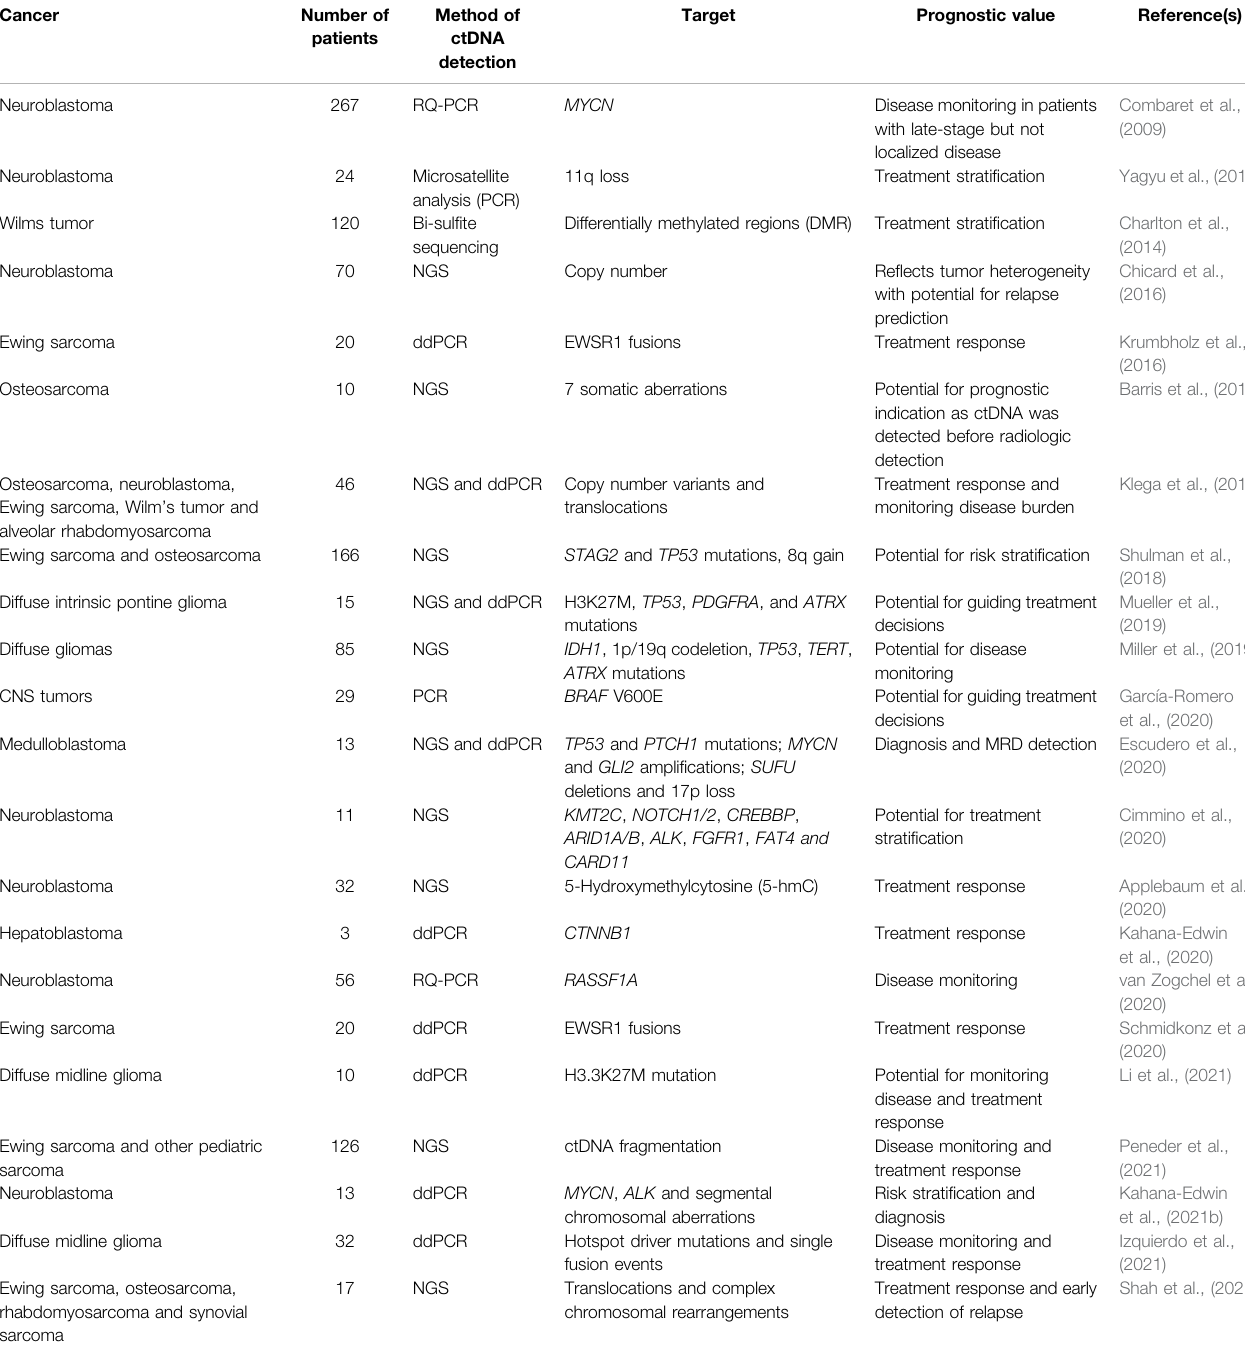
TABLE 1 | Clinical ctDNA studies in pediatric